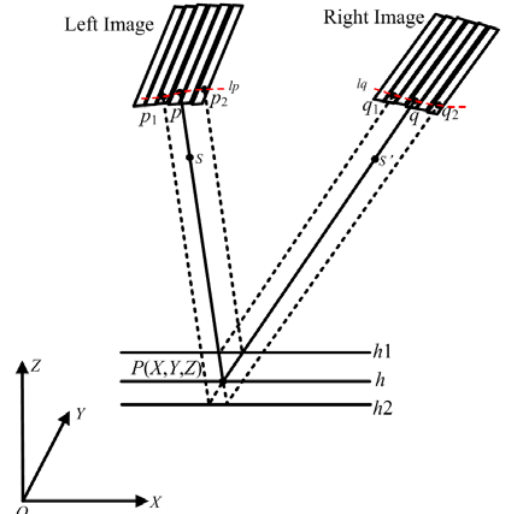
Figure 1. Epipolar geometry of linear pushbroom imagery based on projection